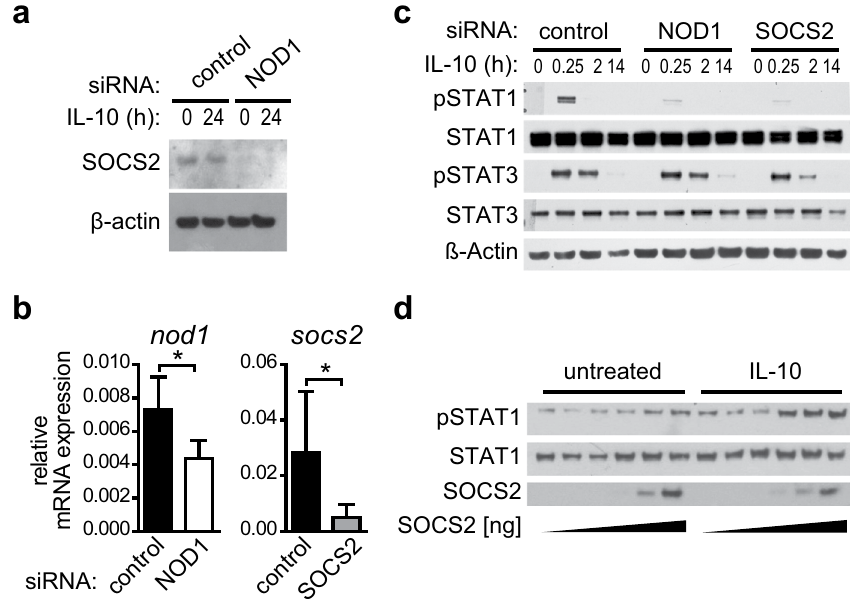
Figure 6. SOCS2 regulates IL-10-dependent STAT1 phosphorylation. ( a ) NOD1 silencing and control silencing were performed in iDCs. After 3 days of silencing, iDCs were induced with IL-10 (30 ng/ml) for 24 hours. SOCS2 and β -actin expression was monitored by Western Blot. One of two experiments is shown. ( b,c) Immature DCs were transfected with a control siRNA or siRNA directed against NOD1 or SOCS2. ( b ) 72 hours post transfection, silencing efficiency was analysed by q-RT-PCR. Data represent mean and SD of three independent experiments. For statistical analysis a Student’s t-test was performed. c Transfected cells were stimulated with IL-10 (30 ng/ml) for the indicated time points to analyse STAT1 and STAT3 phosphorylation by Western Blot. To control for equal loading, total STAT protein and β -actin was detected. One representative experiment out of three is shown. ( d ) HEK293 cells were transiently transfected with expression vectors encoding SOCS2 and the IL-10 receptor subunits IL-10R1 and IL-10R2. 24 hours post transfection, cells were left untreated or stimulated with IL-10 (10 ng/ml) for 20 minutes. STAT1 phosphorylation and SOCS2 expression were analysed by Western Blot. To control for equal loading, total STAT1 was detected. One representative experiment out of three is